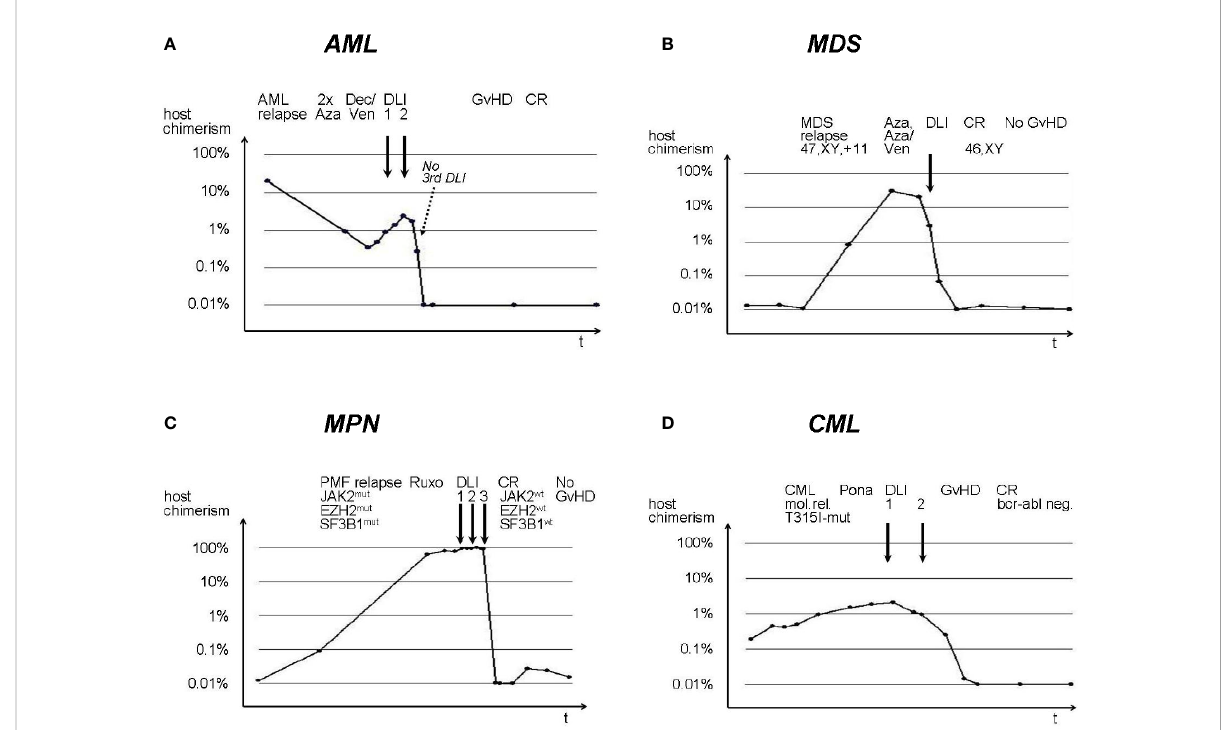
FIGURE 1 Individual hs-chimerism sequences in AML, MDS, MPN, and CML patients with navigated DLI. (A) AML, (B) MDS, (C) MPN, (D) CML. DLI are indicated by solid arrows. Aza, Azacytidine; Ven, Venetoclax; PMF, Primary Myelo fi brosis; Ruxo, Ruxolitinib; Pona, Ponatinib; mut, mutation; wt, wild type. y-axes: host chimerism; x-axes: time after